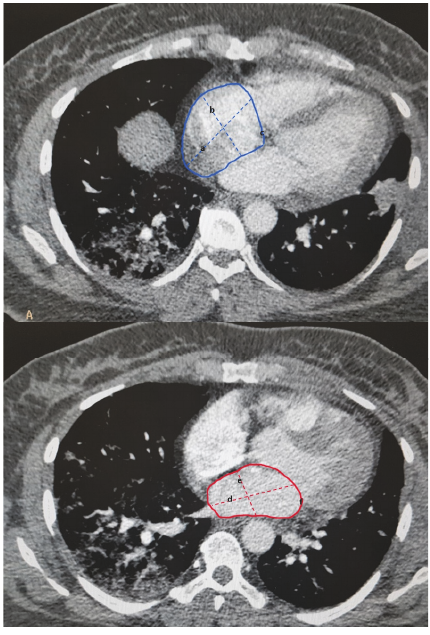
Figure 1: Radiological indices defined in computed tomography pulmonary angiography (CTPA). The figure, depicting a sample of computed tomography pulmonary angiography (CTPA) image and the indices defined for measuring different sizes. a, b, and c imply RA long diameter, short diameter, and area, respectively. d, e, and f imply LA long diameter, short diameter, and area,